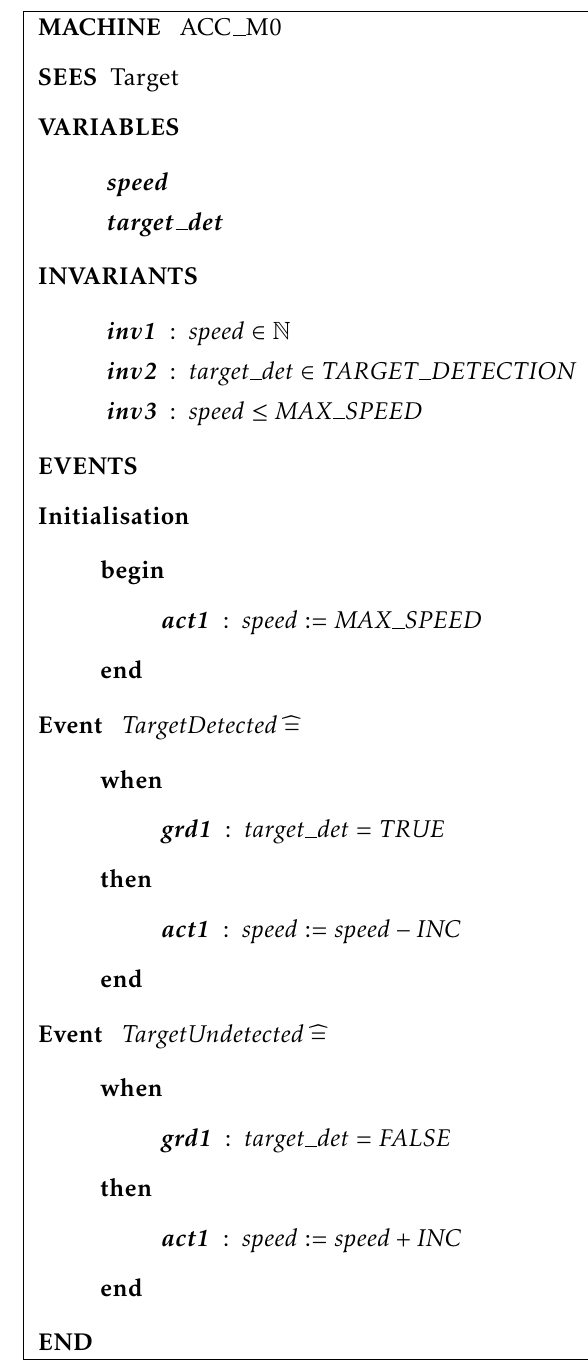
Figure 5. Abstract machine of initial ACC